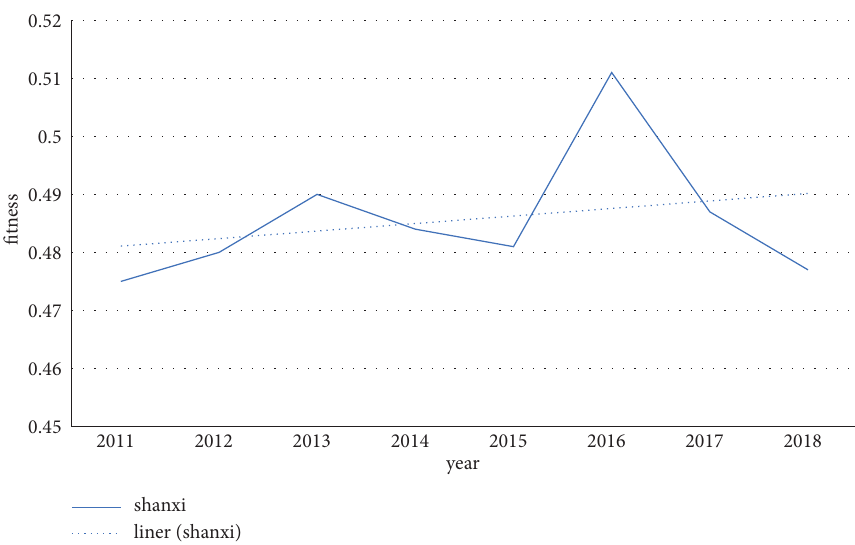
Figure 3: Changes in the niche suitability of innovative ecosystems in Shanxi Province from 2011 to 2018.